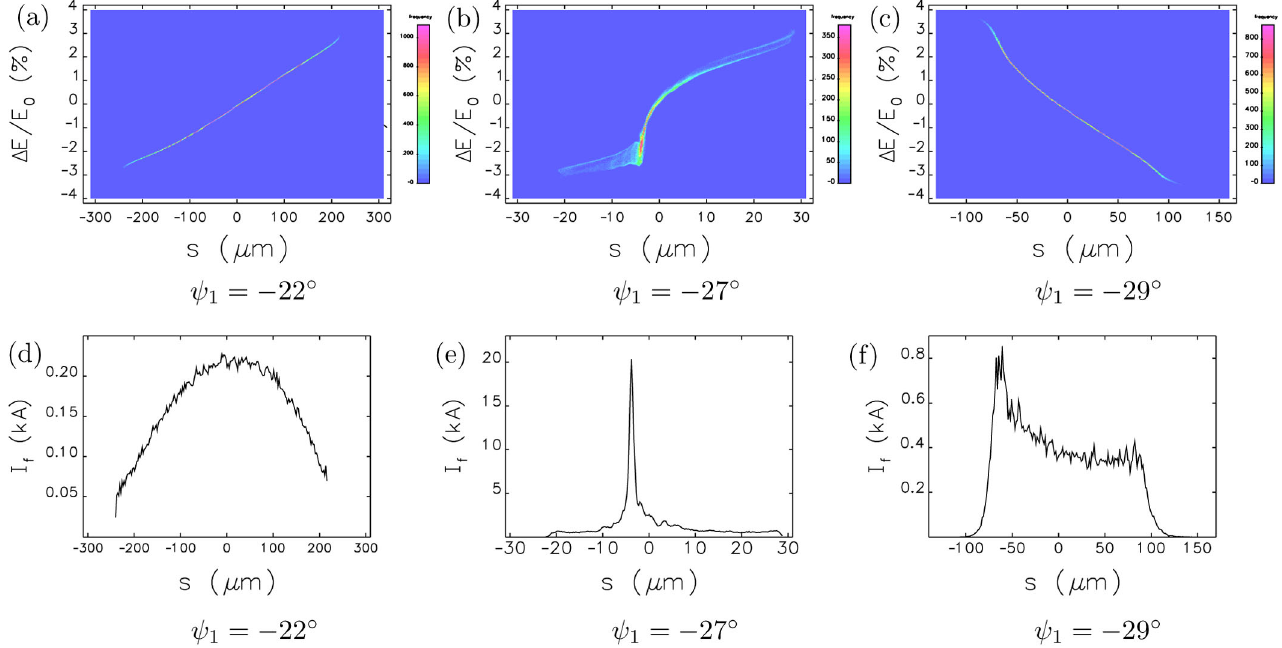
FIG. 7. (Color) ELEGANT simulations of the beam longitudinal phase space distributions (upper plots) and the current profiles (lower plots) after BC1 at 250 MeV for three L1S phases. The bunch head is to the left. (a) c 1 ¼ (cid:2) 22 (cid:1) . (b) c 1 ¼ (cid:2) 27 (cid:1) . (c) c 1 ¼ (cid:2) 29 (cid:1)